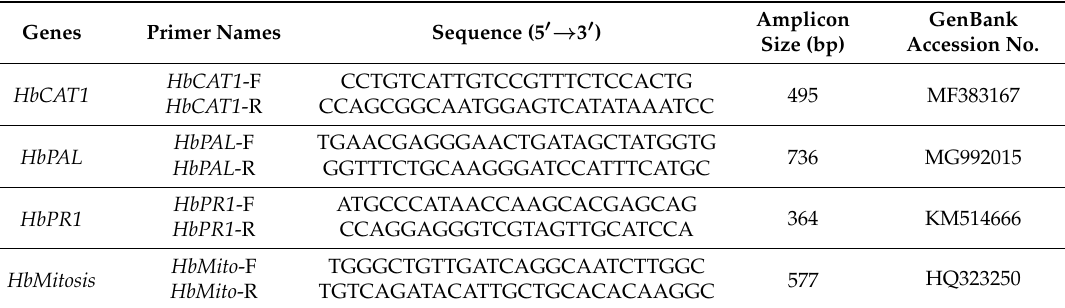
Table 2. Specific primers for